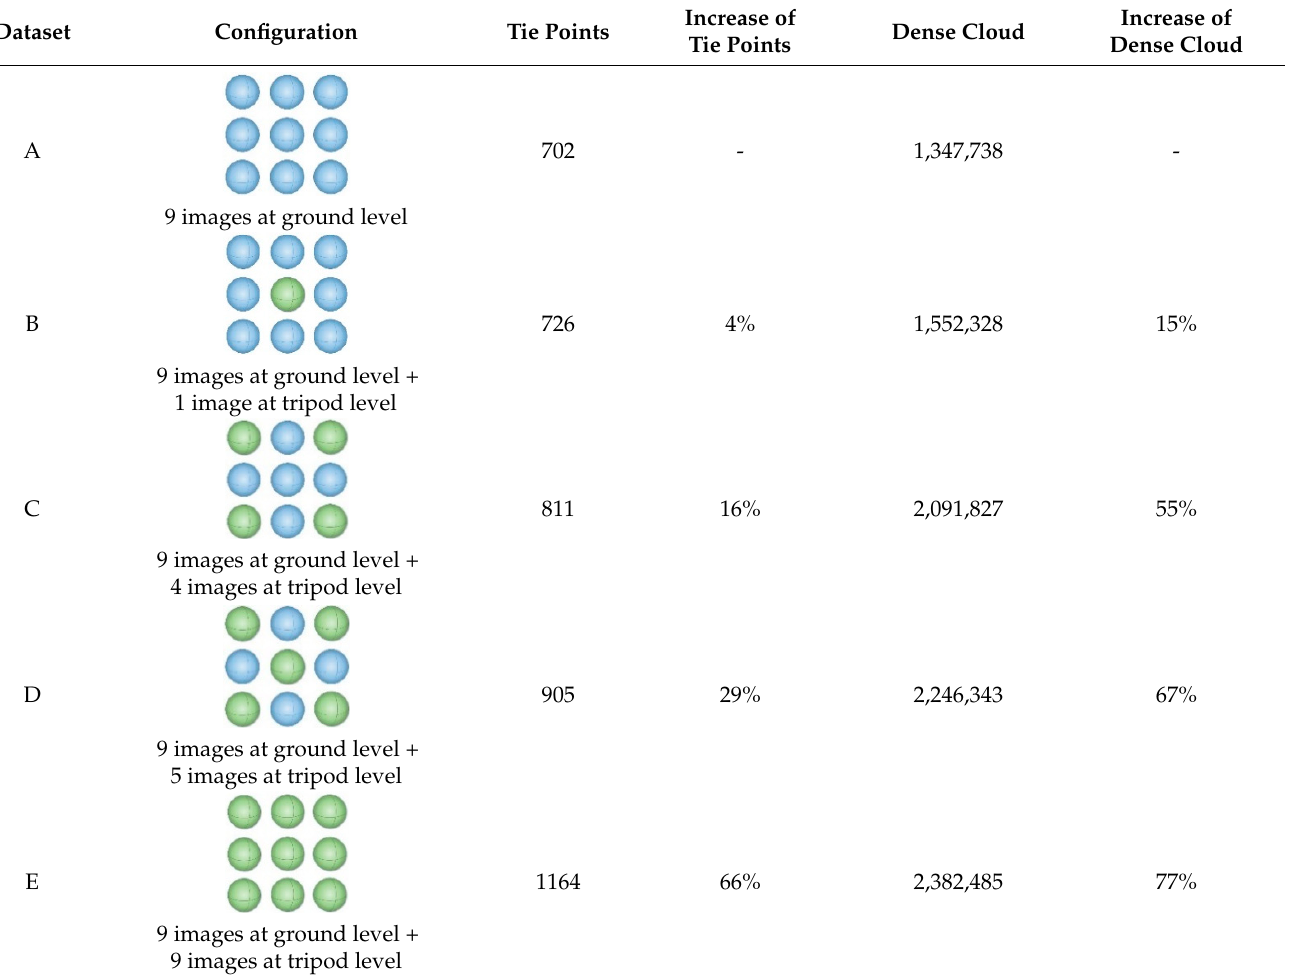
Table 5. Spatial configuration of spherical images and calculation of the increase in the number of tie points and dense clouds.